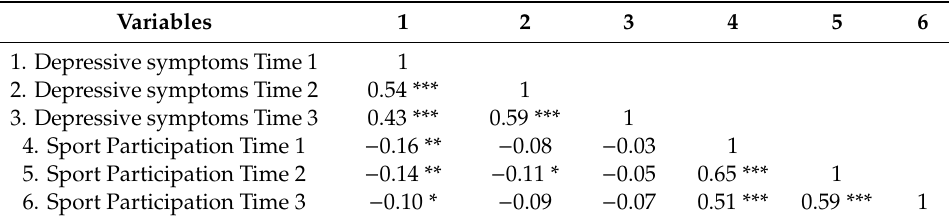
Table 2. Partial correlations between depressive symptoms and frequency of sport participation in all waves, controlling for gender and